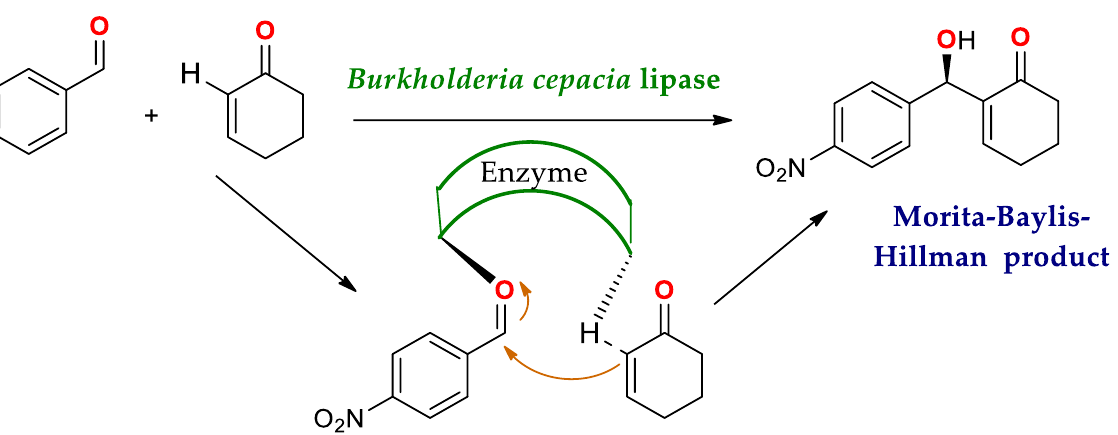
Scheme 16. Representation of the use of the lipase Burkholderia cepacia as promoter of the stereospe- cific Morita – Baylis – Hillman reaction [31], notice that the addition must occur on the re side of the enolate due to the chelation orientation to aldehyde provided by the enzyme.